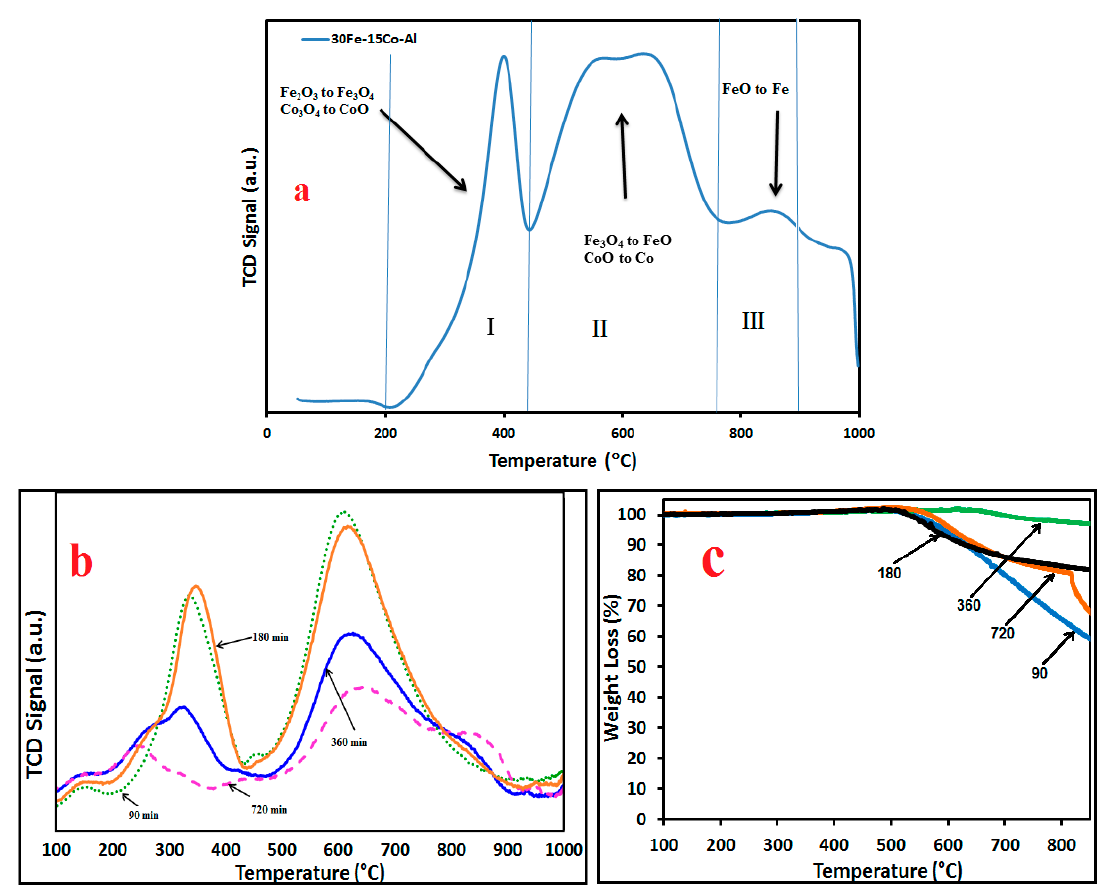
Figure 5. ( a ) H 2 -TPR for fresh catalyst, ( b ) H 2 -TPR for used catalyst, and ( c ) thermogravimetric (TG) profiles, of 30Fe-15Co/Al 2 O 3 catalysts at different regeneration temperatures.